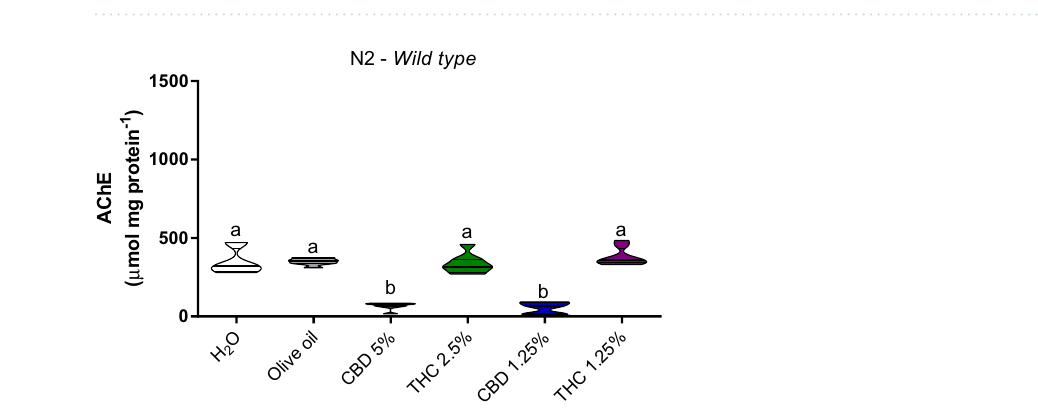
Figure 1. Body bends rate ( A ), pharyngeal pumping rate ( B ), and defecation cycle length ( C ) in C. elegans wild- type strain (N2). Data are expressed by the mean ± standard error (SEM). Means followed by the same letter are not significantly different according to Tukey’s test ( p > 0.05) ( A , C ) or Dunn’s test ( p > 0.05) ( B ).